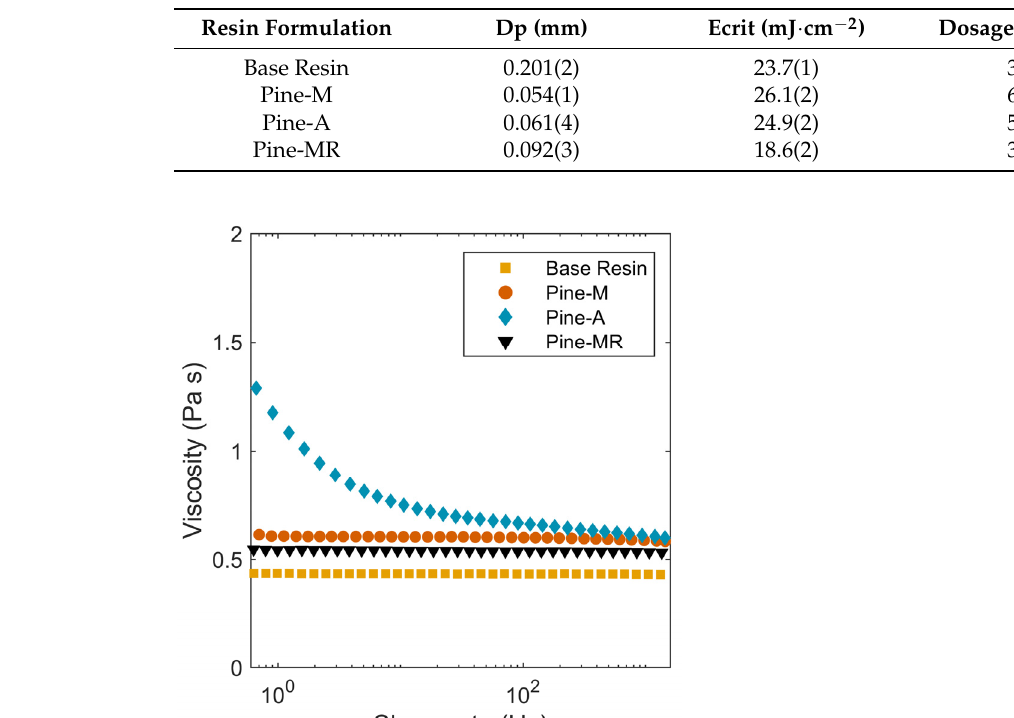
Table 2. Cure parameters for tested resin formulations, including penetration depth (Dp), critical energy (Ecrit), and dosage. The dosage is calculated per layer for a 50 µ m layer height. Error on last digit shown in parenthesis.